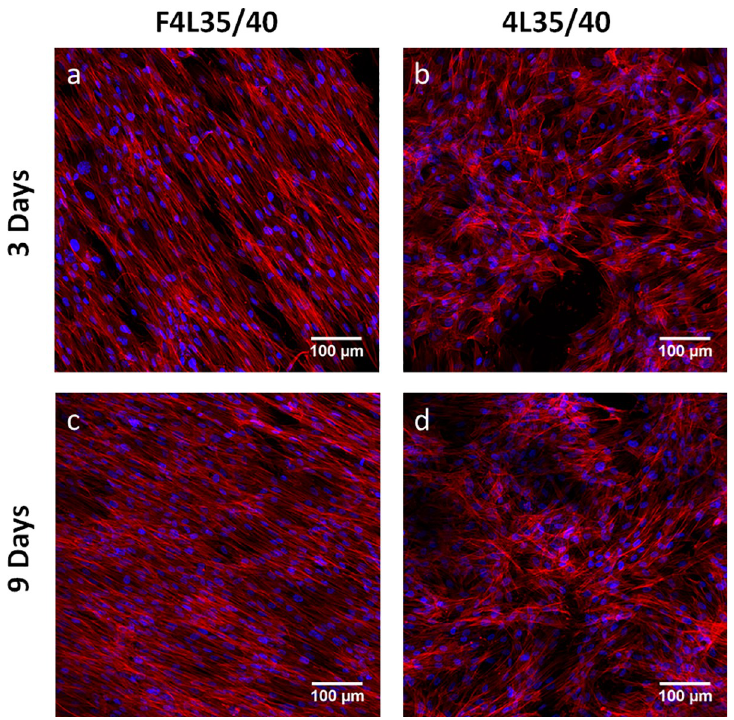
Fig 9. Confocal images of NHDFs A) after 3 days cultured on F4L35/40, B) after 3 days cultured on 4L35/40, C) after 7 days cultured on F4L35/40 and D) after 7 days cultured on 4L35/40. Actin stained with Phalloidin-TRITC (red) and nuclei stained with DAPI